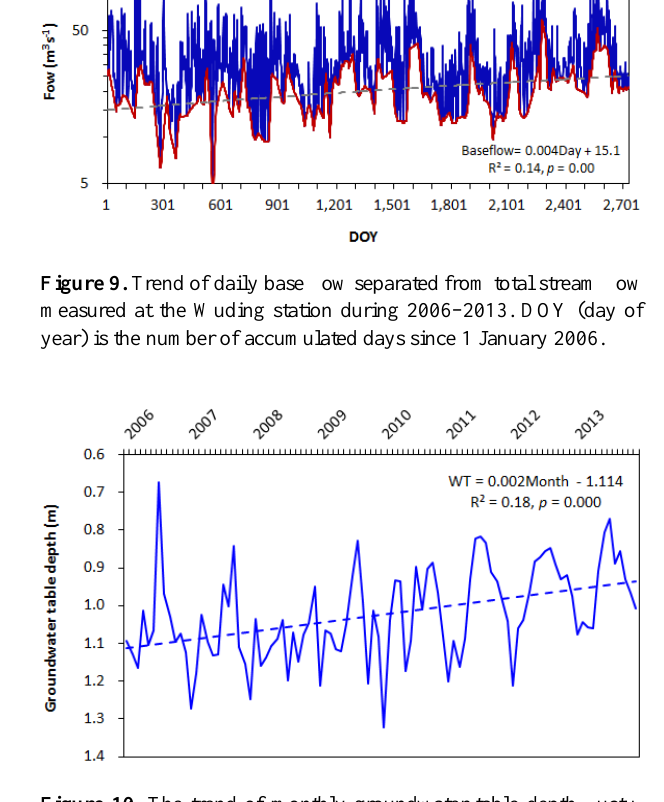
Figure 10. The trend of monthly groundwater table depth fluctu- ations measured at the Aiyuan well station in the Lishui subbasin during